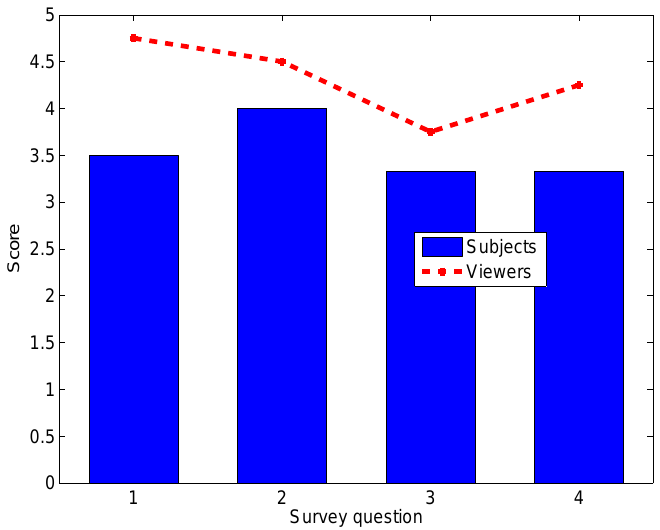
Figure 8. User survey score from the subject and the